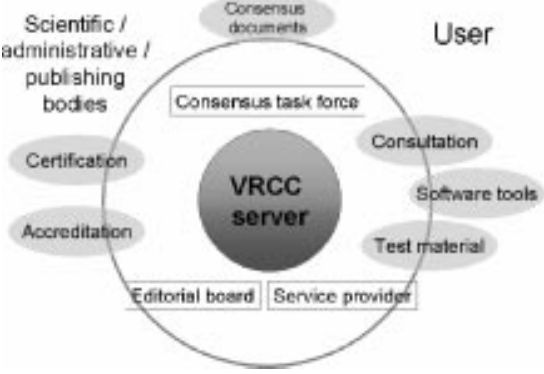
Fig. 1. Schematic structure of a VRCC and its relations to